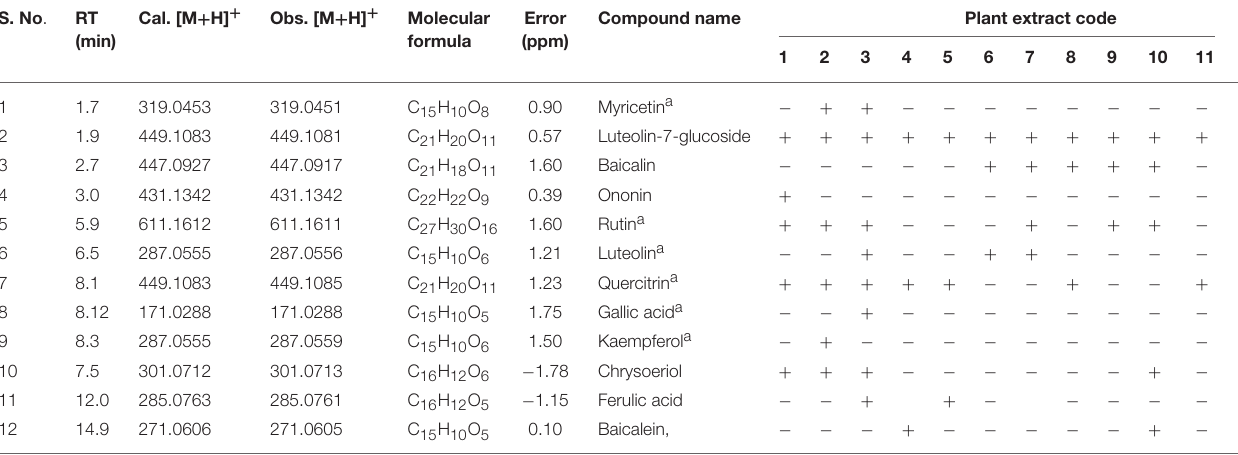
TABLE 3 | Detection of phenolic compounds by HPLC-DAD-ESI-TOF-MS in selected 12 plant extracts. S. No . Obs. [M + H] + Molecular